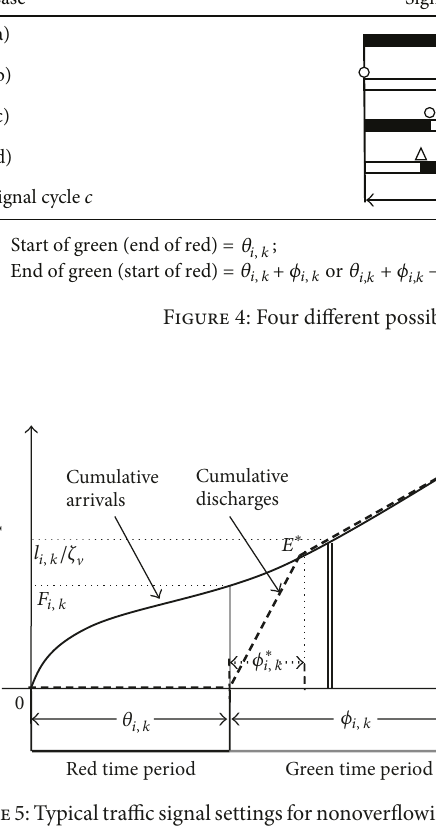
Figure5:Typicaltrafficsignalsettingsfornonoverflowingapproach lane 𝑘 from leg 𝑖 .